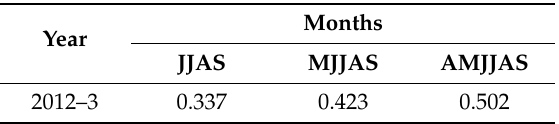
Table A3. Proportion of Indian annual electricity generation for the respective groups of months on and/or preceding the monsoon season for 2012–13 [26,27].